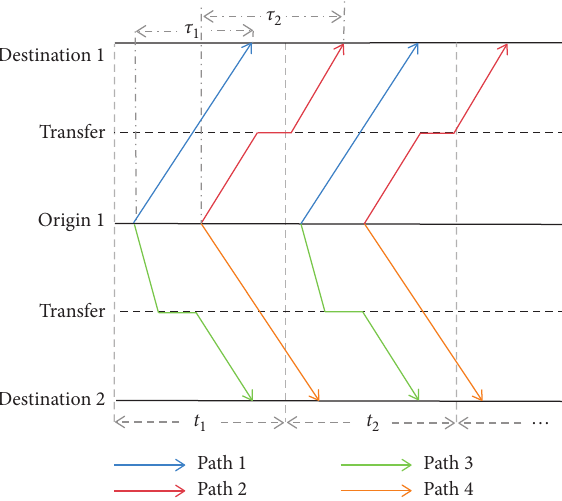
Figure 2: Illustration of the time-space passenger